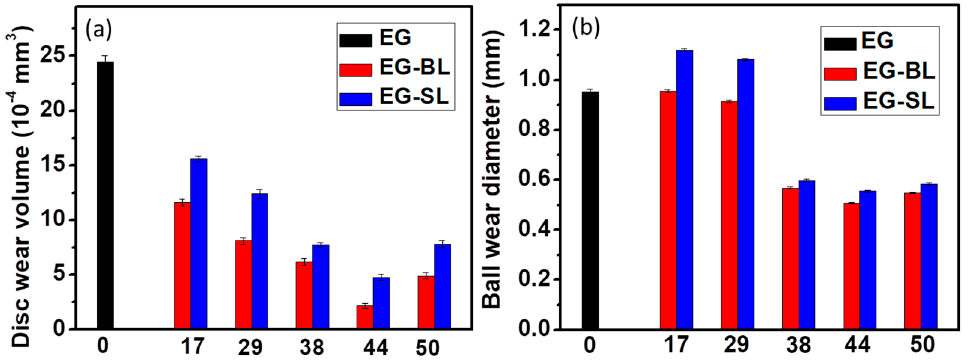
Figure 5. Disc wear volume ( a ) and ball wear diameter ( b ) lubricated by two EG-based lubricants. Load: 2.5 GPa, testing duration: 1 h, temperature: 25 °C.